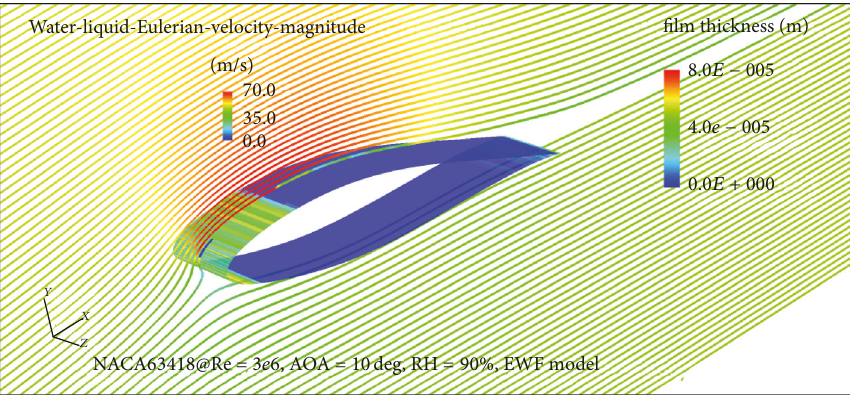
Figure 10: Contour plots of water film thickness around airfoil for AOA = 10 degrees (EWF model).